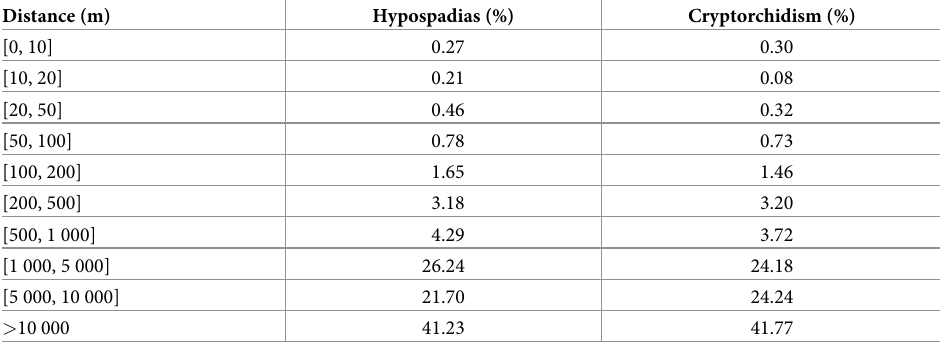
Table 2. Proportions of hypospadias and cryptorchidism in different classes of distance to the nearest vineyard. Distance (m) Hypospadias